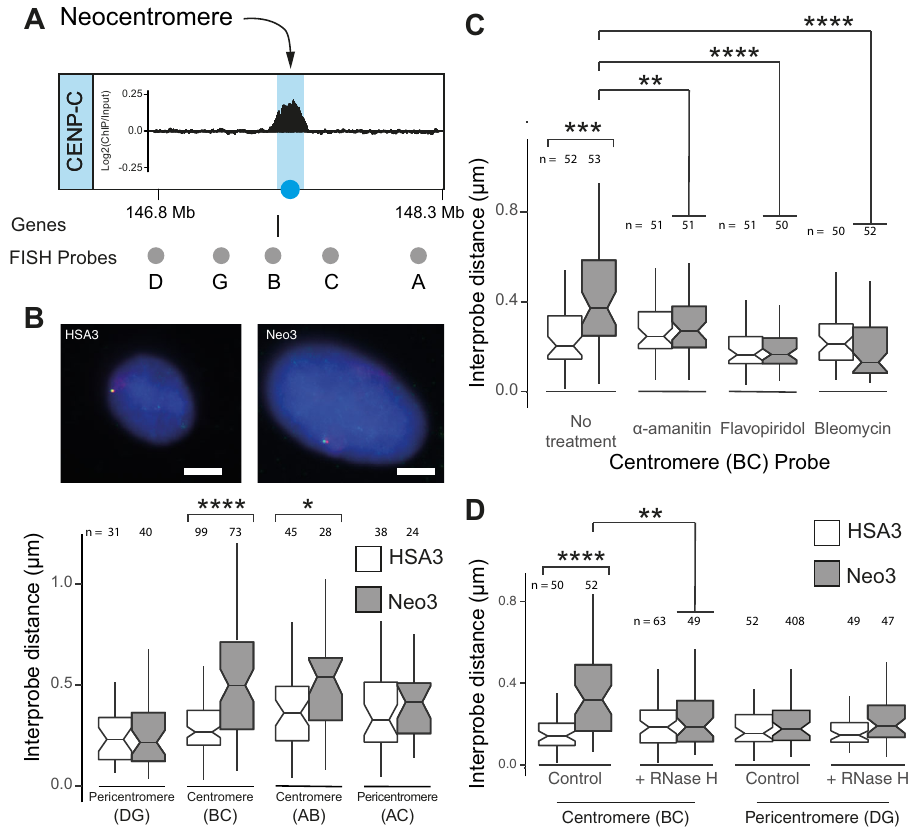
Fig. 6 | Large-scale neocentromere chromatin fi bre decompaction. A Diagram showing fosmid FISH probes (grey circles) surrounding the CENPC-marked cen- tromericcoredomain(blue). B Top,representativeimagesof3D-FISHonHSA3and Neo3 chromosomes hybridised to probe B (red) and C (green) in single chromo- somehuman-hamsterhybridnuclei,counterstainedwithDAPI.Baris5 µ m.Bottom, boxplot showing interprobe distance measurements ( µ m) for pairs of fosmid probes. Exact p values for a Wilcoxon test were (BC) 3.29e – 01 and (AB) 0.02505. C Boxplot showing interprobe distance ( µ m) between the BC (centromere) fosmid probesinHSA3(white) and Neo3(grey)chromosomes in GM10253A and HybNeo3 cell lines respectively, after treatment with α -amanitin (5h), fl avopiridol (3h) or